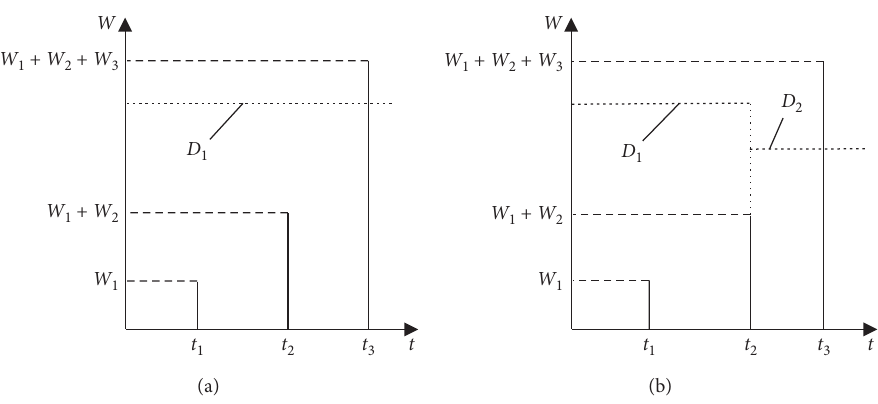
Figure 2: Hard failure process: (a) fixed threshold; (b) shifting